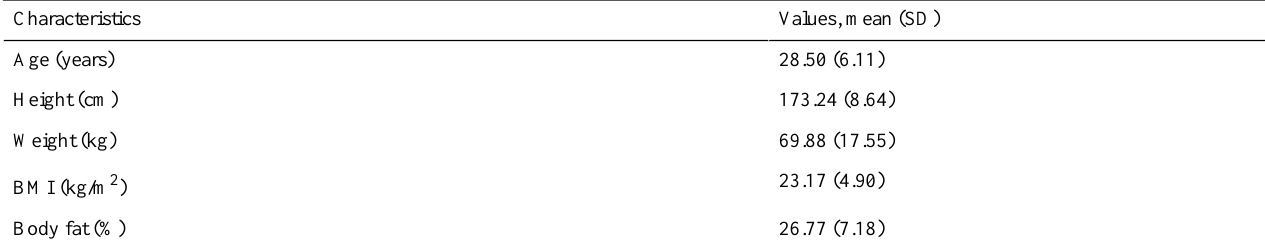
Table 1. Participant demographics